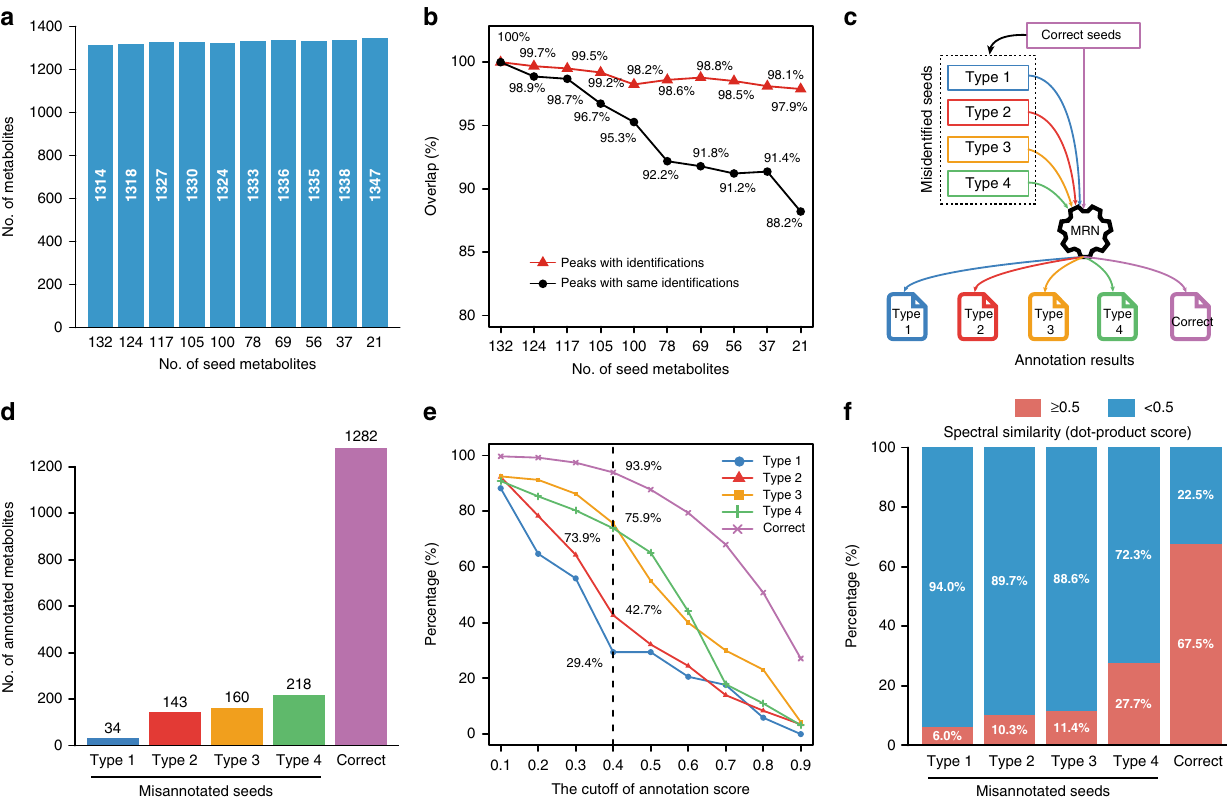
Fig. 4 MetDNA is robust to small size library and has low propagation of misannotated metabolites. a The numbers of annotated metabolites using different numbers of initial seed metabolites. b The in fl uence of the initial seed number on the annotations to mimic the different sizes of the tandem libraries. Red triangles represent the overlap percentages of MS1 peaks with annotations using different initial seed metabolites. Black circles represent the overlap percentages of MS1 peaks with the exact same annotations using different initial seed metabolites. In both cases, the annotation result using all 132 seed metabolites is used as a control. c The experimental design to evaluate the propagation of misannotated seed metabolites by replacing the correct seeds with four types of misannotated seeds. The types of misannotated seeds were de fi ned as: Type 1: metabolites with mass errors were large than 25 ppm, and RT error were less than 60 s; Type 2: metabolites with mass errors were within 25 ppm, but RT error large than 60 s; Type 3: metabolites with mass errors and RT errors were within 25 ppm and 60 s, respectively; Type 4: metabolites with mass errors were within 25 ppm, but RT error were large than 60 s, and have high MS2 spectral similarity with seed metabolite (dot-product score was higher than 0.8). d The numbers of annotated metabolites using the correct and four types of misannotated seed metabolites. e The in fl uence of the cutoff of annotation score on the numbers of annotated metabolites using the correct and four types of misannotated seed metabolites. f Spectral similarity between the correct and four types of